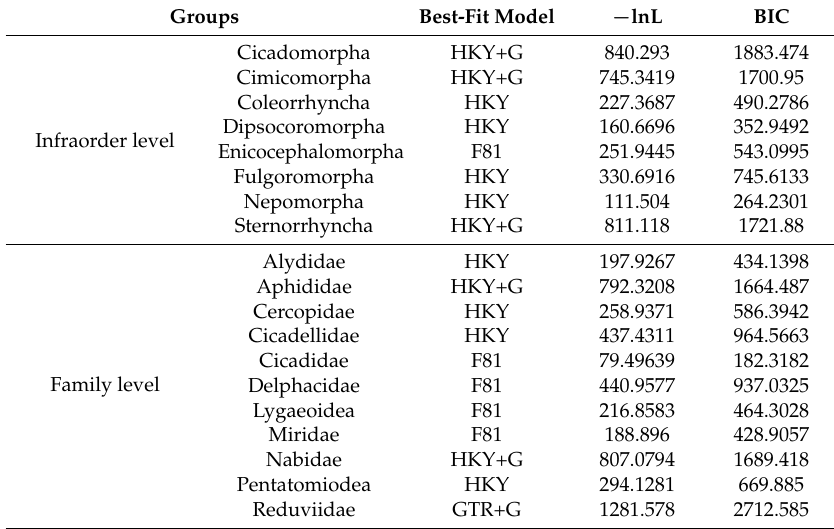
Table 1. The best-fit models among groups.